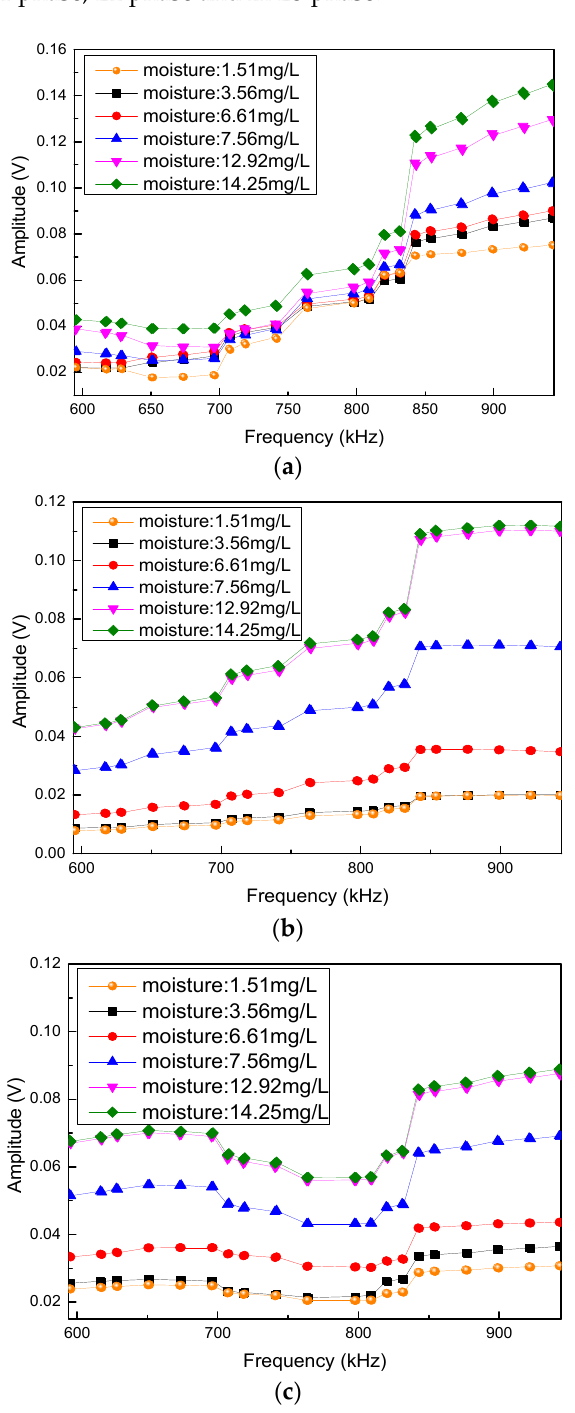
Figure 3. Spectrum curve of ultrasonic signal. ( a ) Amplitude response of L1 phase of multi-frequency ultrasonic detection; ( b ) Amplitude response of L2 phase of multi-frequency ultrasonic detection; ( c ) Amplitude response of L3 phase of multi-frequency ultrasonic detection.